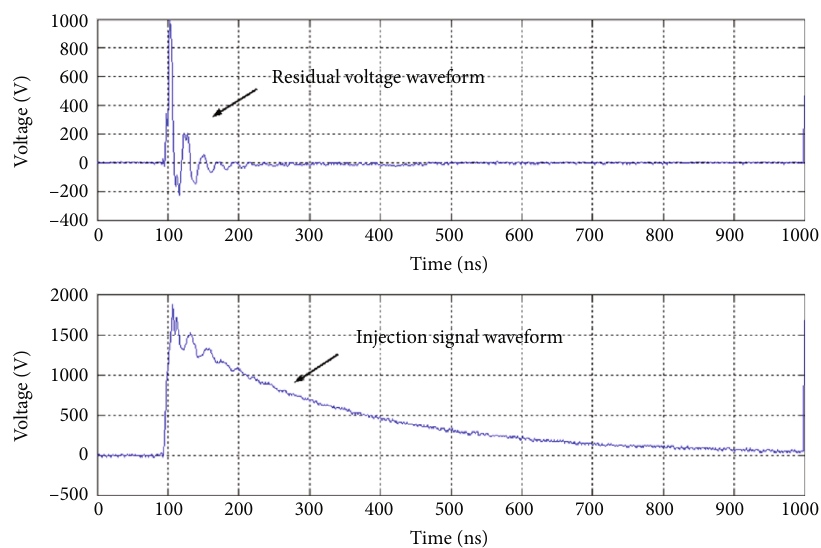
Figure 1: Waveforms before and after narrow pulse input to gas discharge